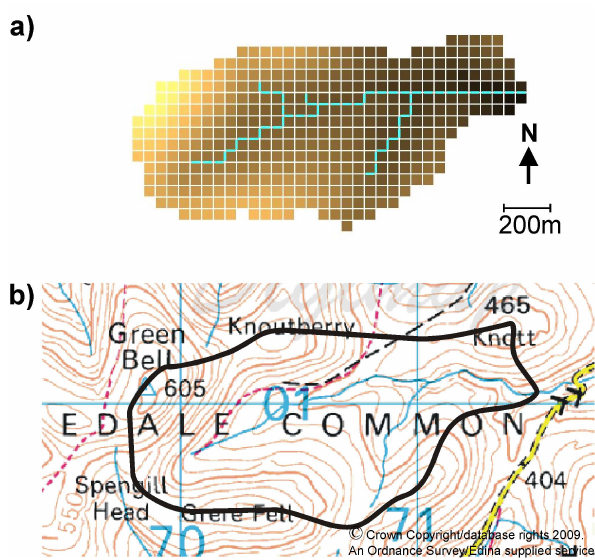
Fig. 1. Gais Gill Catchment, Upper Eden, Northern England. (a) SHETRAN mesh (50m grid squares) (b) map of